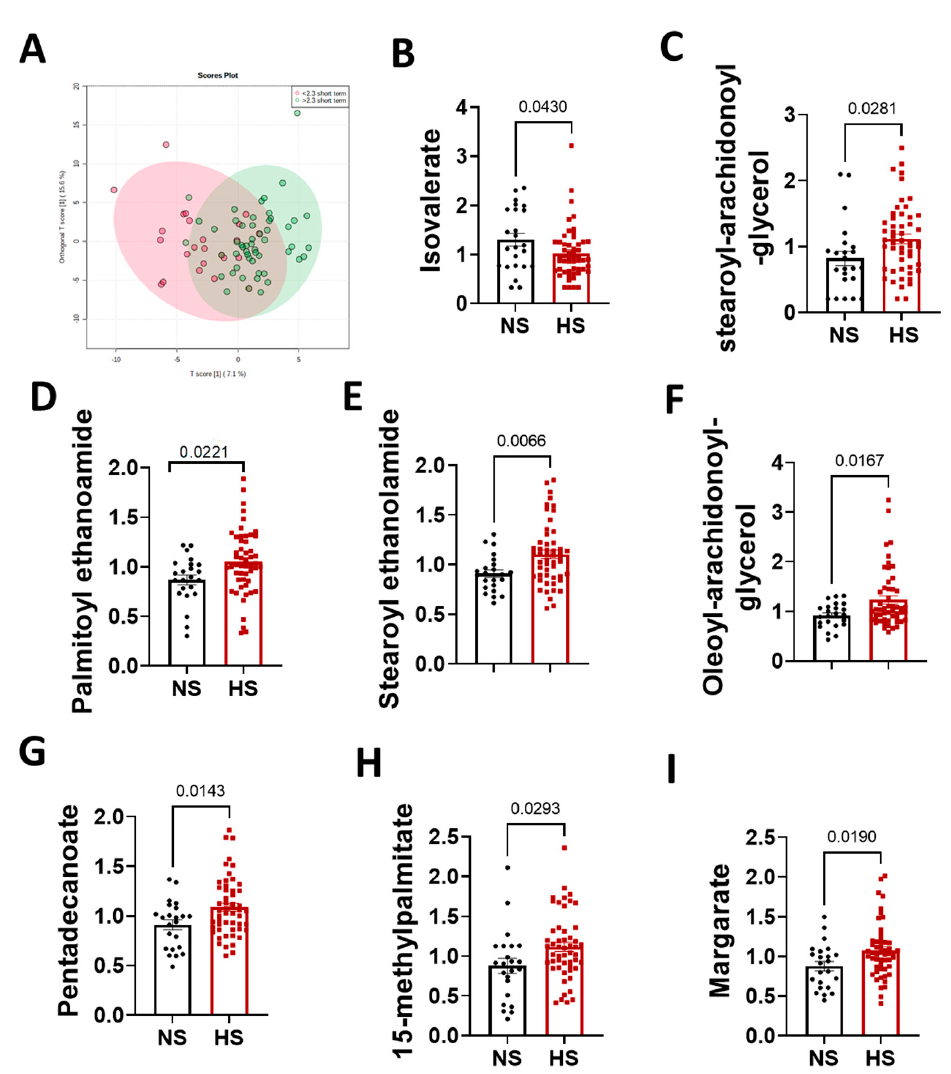
Figure 3. A high-salt diet is associated with changes in plasma fatty acid metabolites. ( A ) Principal component analysis in normal versus high salt fatty acid levels; ( B ) isovalerate; ( C ) stearoyl-arachidonoyl-glycerol; ( D ) palmitoyl ethanolamide; ( E ) stearoyl ethanolamide; ( F ) oleoyl-arachidonoyl-glycerol; ( G ) pentadecanoate; ( H ) 15-methylpalmitate; and ( I ) margate. ( p -values were determined using 2-tailed unpaired Student’s t tests). NS: normal salt ( n = 23). HS: high salt ( n = 52).